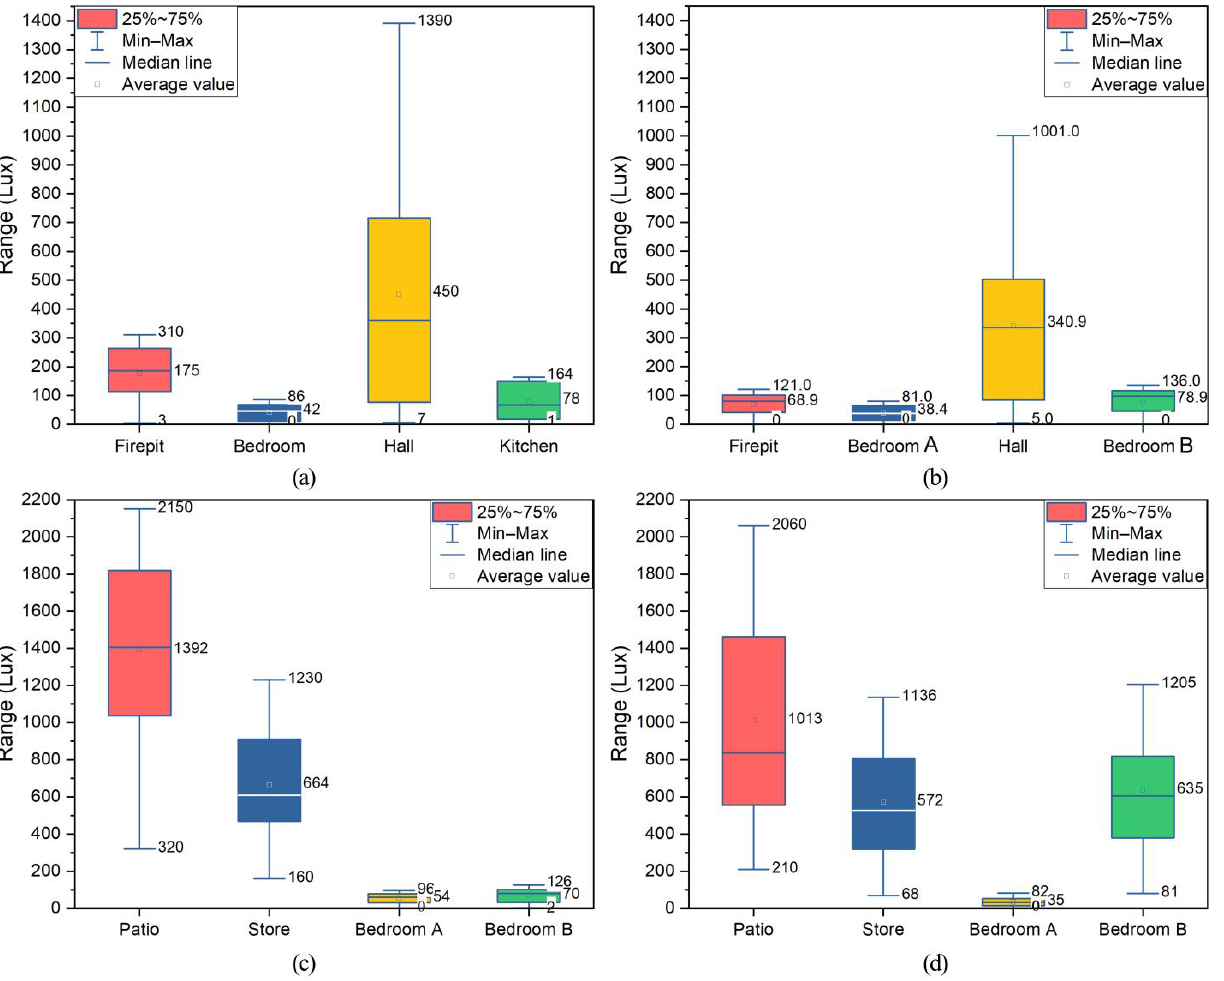
Figure 14. Analysis of light intensity during indoor fires in ancient Tujia town dwellings. ( a ) Zuozi dwelling, ( b ) L-shape dwelling, ( c ) lower store and upper house dwelling, ( d ) front store and back house dwelling.